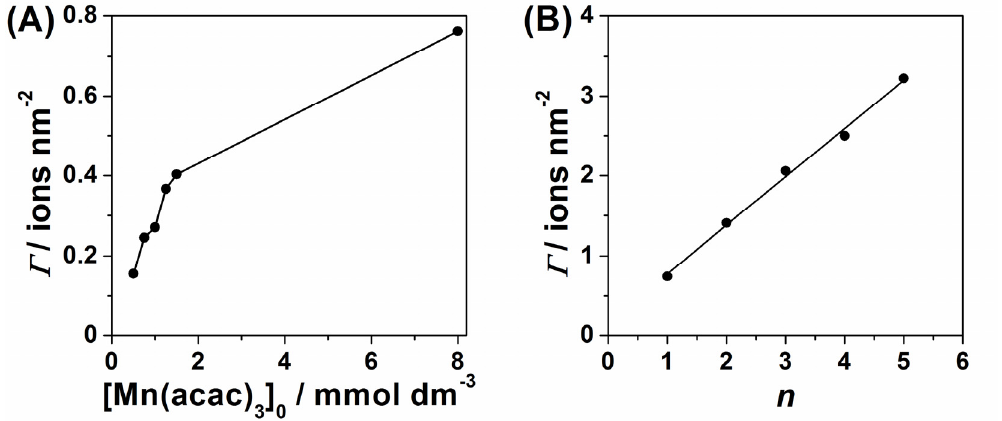
Figure 1. ( A ) Plots of the Mn-loading amount ( Γ /ions nm − 2 ) versus initial concentration of Mn(acac) ([Mn(acac) ] ); ( B ) Plots of Γ versus chemisorption-calcination cycle number 3 3 0 ( n ) at [Mn(acac) ] = 8 mmol dm − 3 . 3 0